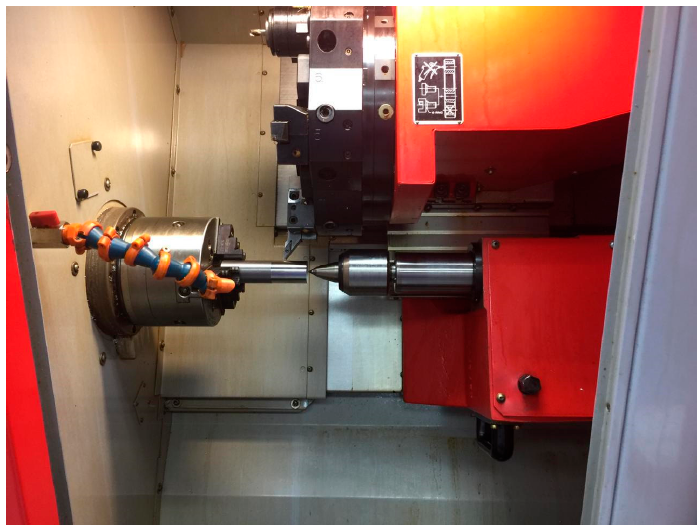
Figure 1. Test rig used for high ‐ speed machining of Ti ‐ 6Al ‐ 4V.